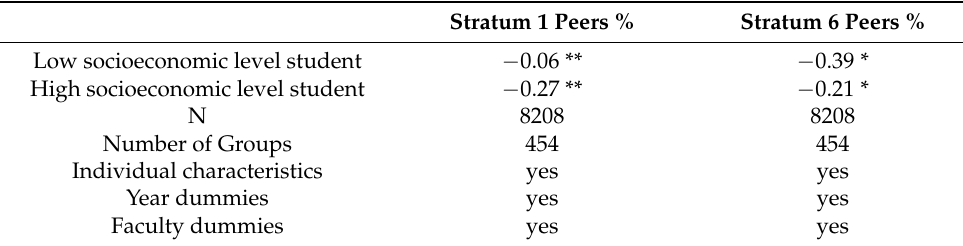
Table 10. Effects of heterogeneous peers according to student’s academic performance in Communi- cation Skills